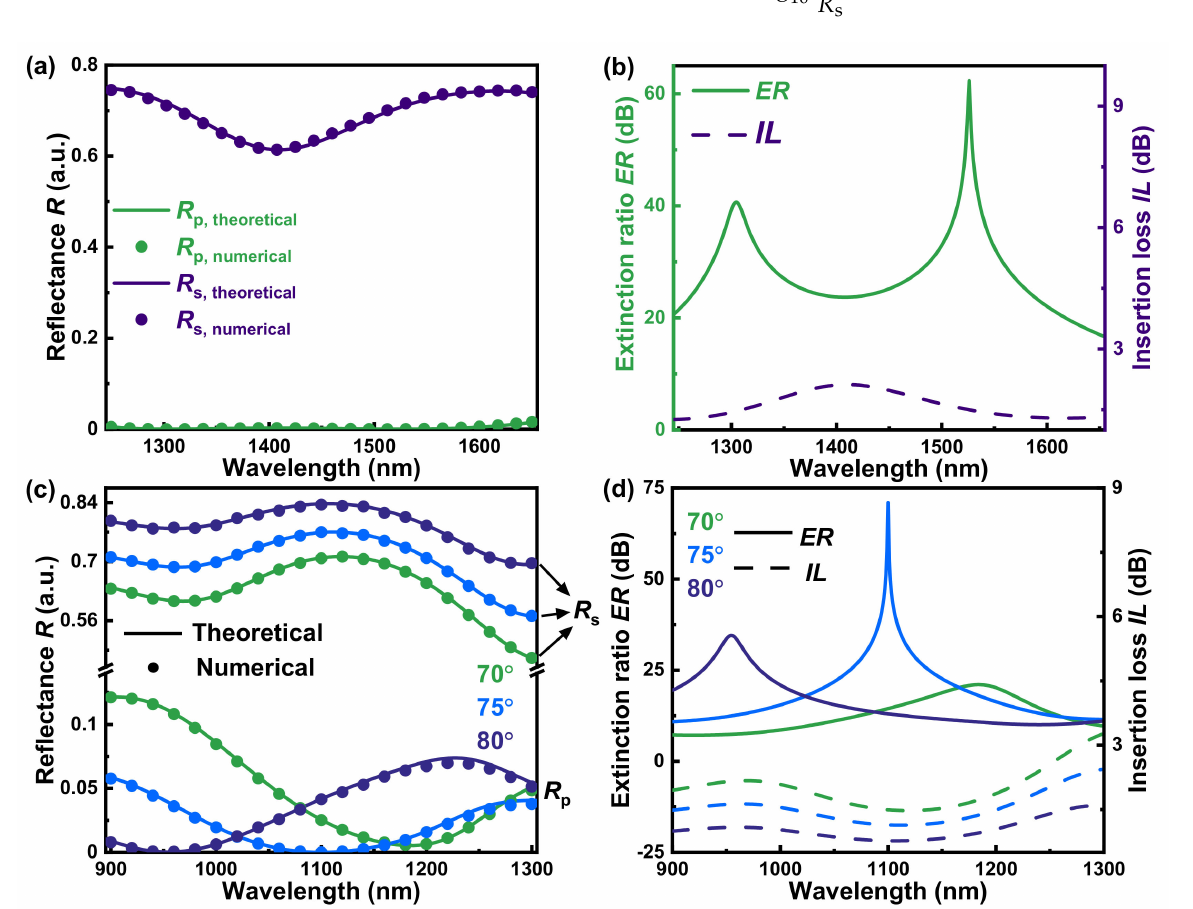
Figure 3. The broadband near-infrared polarizer based on SnSe-SiO 2 -Si multilayer structure with SnSe’s thickness of 400 nm and SiO 2 ’s thickness of 675 nm: ( a ) the theoretical and numerical reflectance of p and s light at the incident angle of 75 ◦ and ( b ) the corresponding theoretical extinction ratio ER and insertion loss IL . The incident-angle-modulation near-infrared polarizer based on SnSe-SiO 2 -Si multilayer structure with SnSe’s thickness of 315 nm and the same SiO 2 ’s thickness ( d SiO ( c ) the theoretical and numerical reflectance of p and s light at the incident angle of 70 ◦ , 75 ◦ , and 80 ◦ and ( d ) the corresponding theoretical extinction ratio ER and insertion loss IL at the same incident